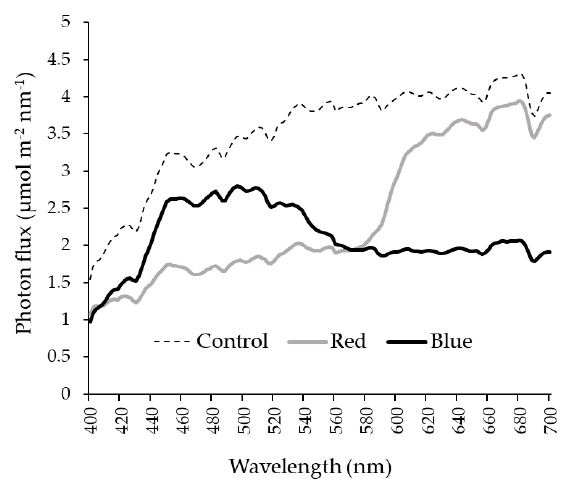
Figure 2. Spectral irradiance pattern measured in apple trees grown under blue, red and white control